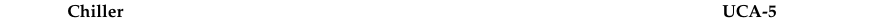
Table 4. Partial List of Loss